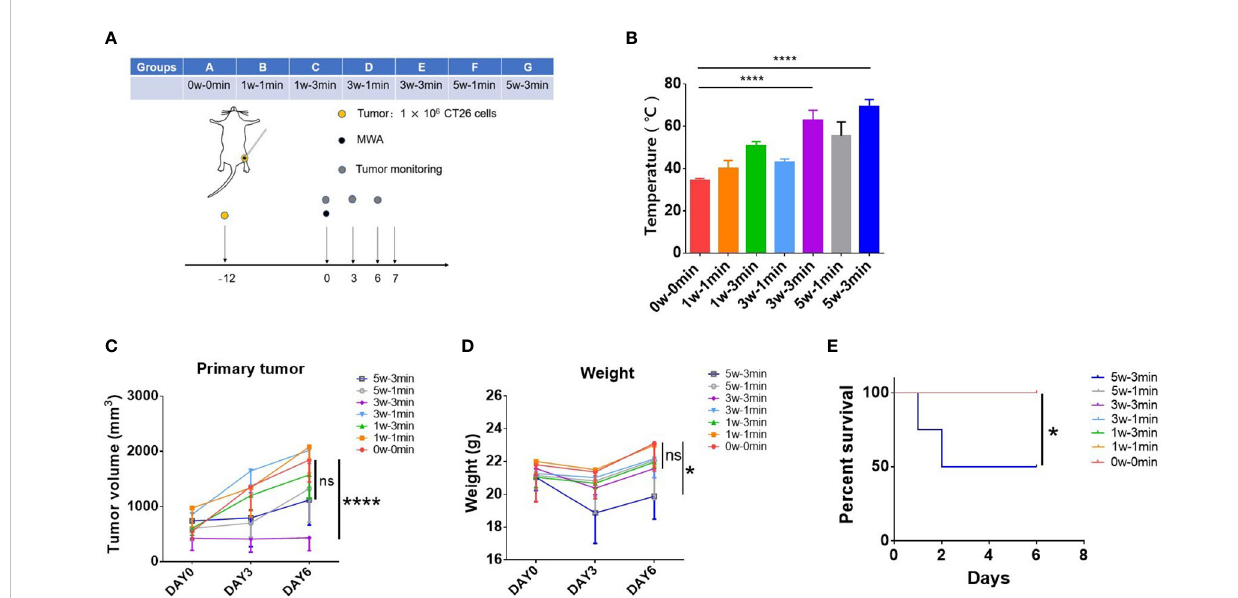
FIGURE 1 MWA at 3 w – 3 min exhibited better antitumor ef fi cacy but less toxicity in CT26 tumor-bearing mice. (A) Balb/c mice were inoculated with CT26 cells. Tumors were treated with MWA (n = 4 in each group) when the tumor size reached 250 – 500 mm 3 in volume. (B) The temperature of tumors was determined following MWA. ****p < 0.0001. (C) The growth of the tumor was observed during the observation period. ****p < 0.0001; ns, p > 0.05. (D) The weight of tumor-bearing mice after MWA treatment was determined during the observation period. *p<0.05; ns, p > 0.05. (E) Kaplan – Meier curves illustrated the survival of mice treated with MWA with different ablation powers or times. *p <